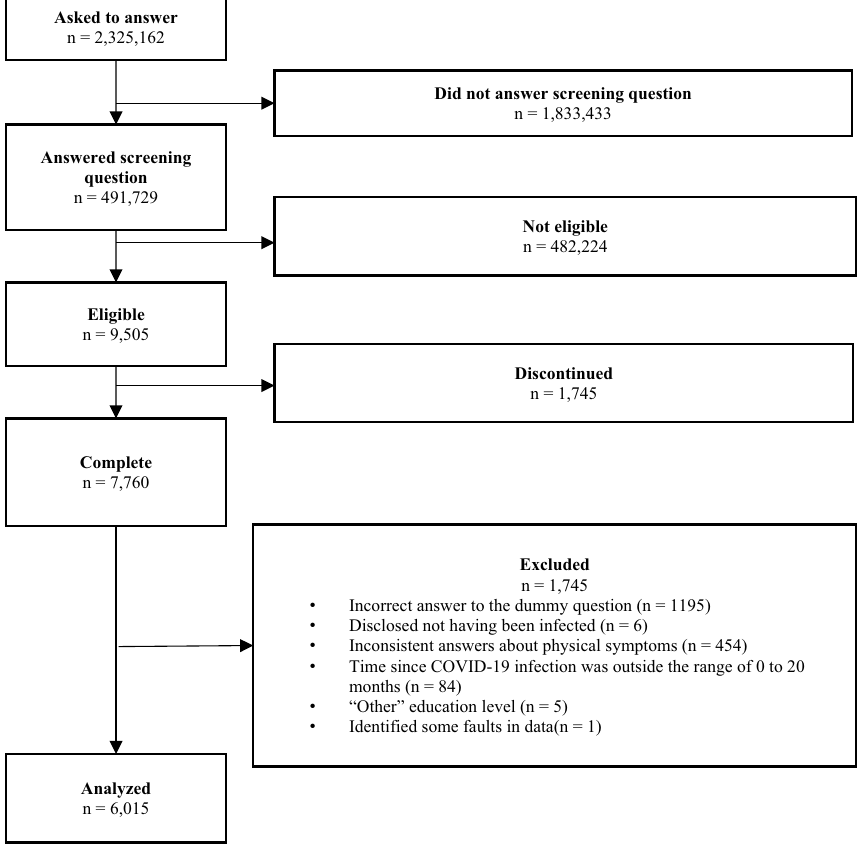
Figure 1. Participant flow